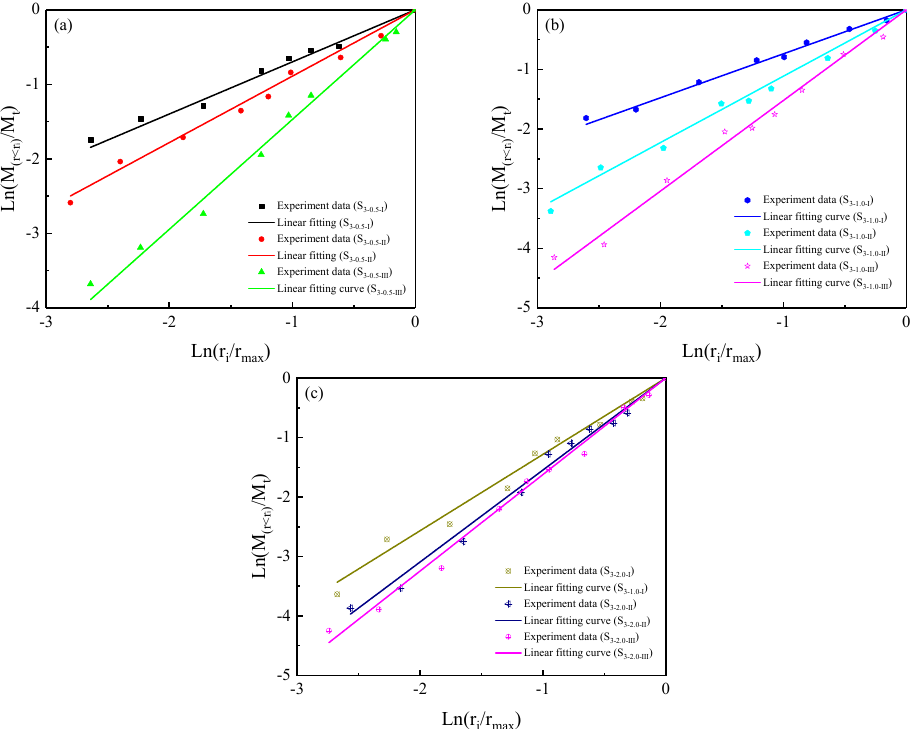
Figure 9. Fractal characteristics of fragments from S 3 series samples: ( a ) T = 0.5; ( b ) T = 1.0; ( c ) T = 2.0.